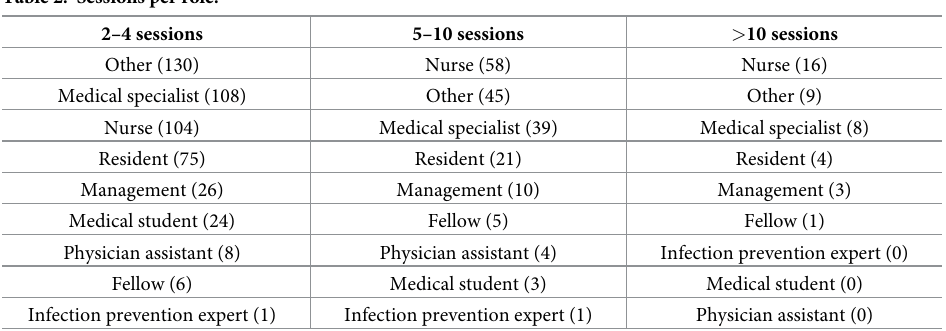
Table 2. Sessions per